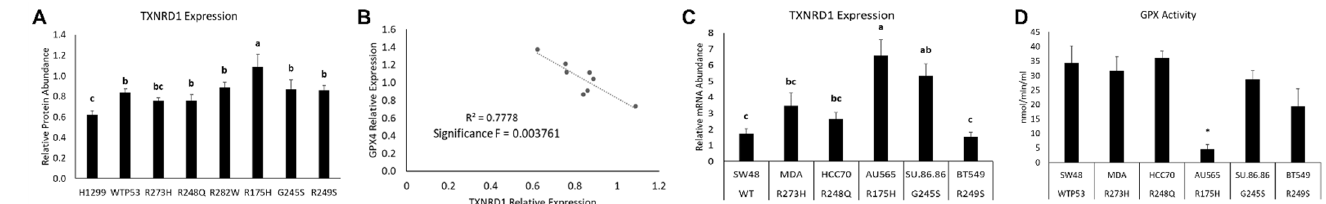
Figure 6. TXNRD1 protein levels in mutant TP53-expressing cells correlates with GPX abundance and activity. ( A ) Relative abundance of TXNRD1 protein levels in TP53 null H1299 cells (H1299), or H1299 cells expressing tetracycline inducible plasmids containing either wild-type TP53 (WTP53) or one of the designated TP53 mutation types was measured by quantitative LC MS/MS following 48 h treatment with 10 µM tetracycline. ( B ) TXNRD1 protein abundance is inversely correlated to GPX protein abundance in H1299 TP53 null, WTP53, and TP53 mutant-expressing cell lines. ( C ) TXNRD1 mRNA expression was measured by qPCR in human cancer cell lines expressing endogenous WT TP53, or one of the TP53 mutation types indicated. ( D ) GPX activity in cells expressing endogenous WT and mutant TP53 was measured indirectly via a coupled reaction with glutathione reductase and normalized to total protein. * Denotes statistical difference from respective control, * p < 0.05. Superscripts (a, b, c) denote statistical difference between TP53 subtypes. Subtypes with the same superscripts are not statistically different. Error bars indicated SEM.